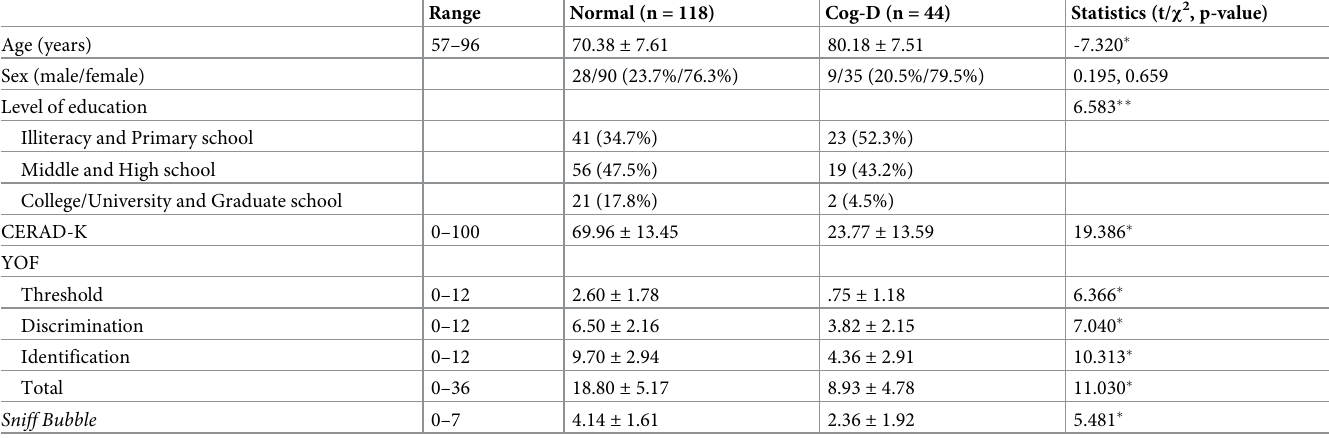
Table 2. Demographic characteristics of the study population (N =